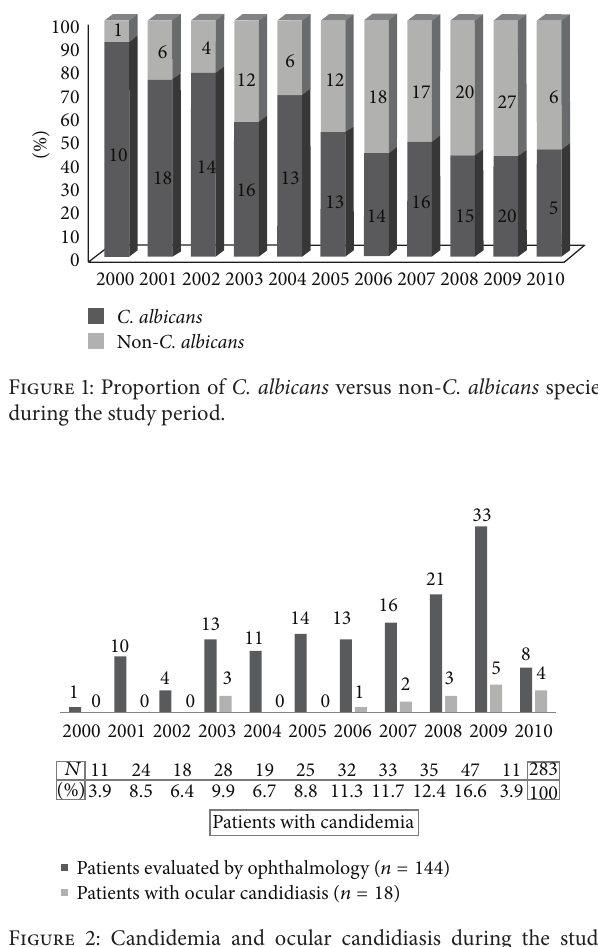
Figure 2: Candidemia and ocular candidiasis during the study